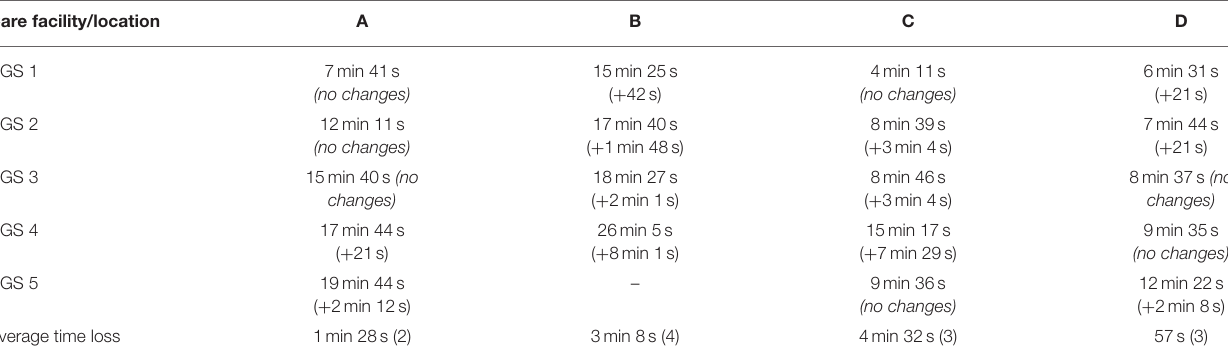
TABLE 3 | Access to the five nearest urban green spaces (UGS) in terms of time without barriers and time loss as a result of barriers (in brackets). Care facility/location